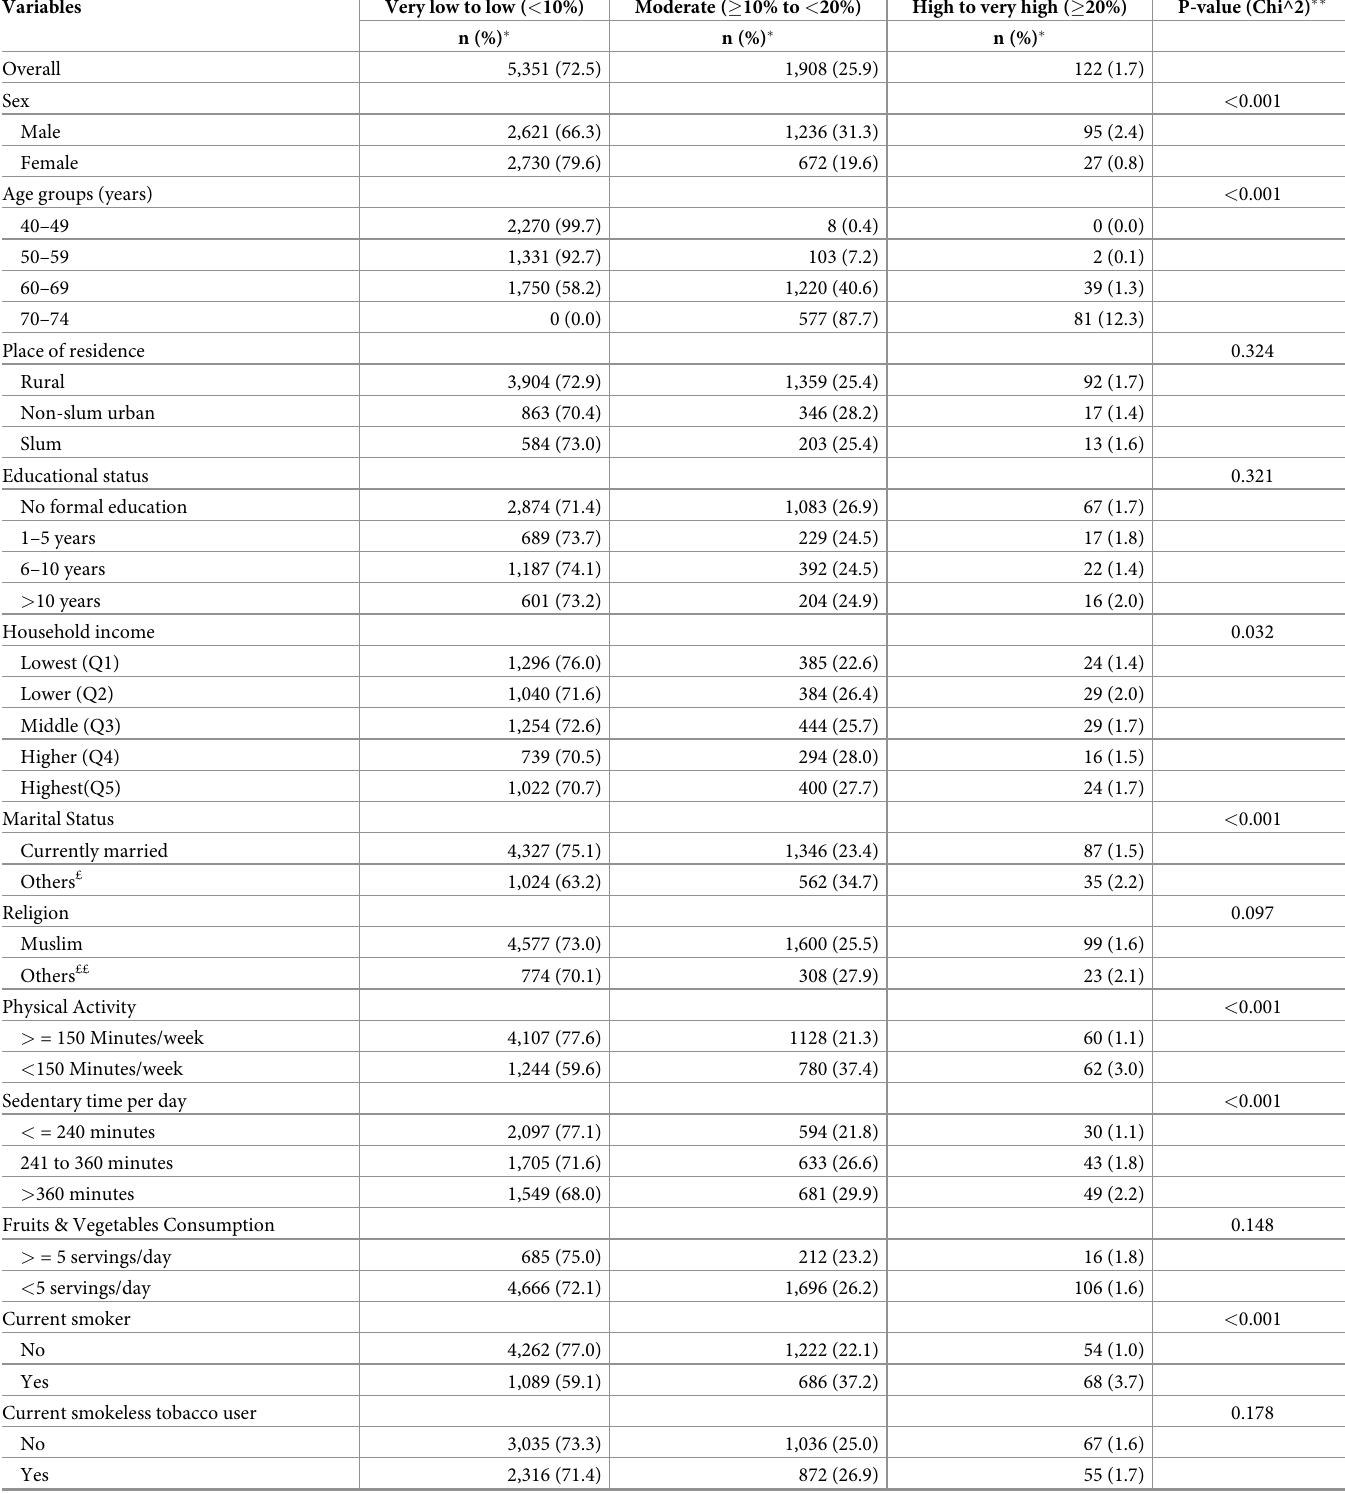
Table 2. Distribution of 10-years risk of fatal or non-fatal cardiovascular risk, according to background